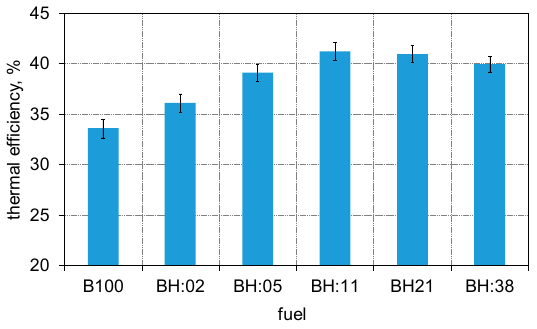
Figure 5. Thermal efficiency of test engine.